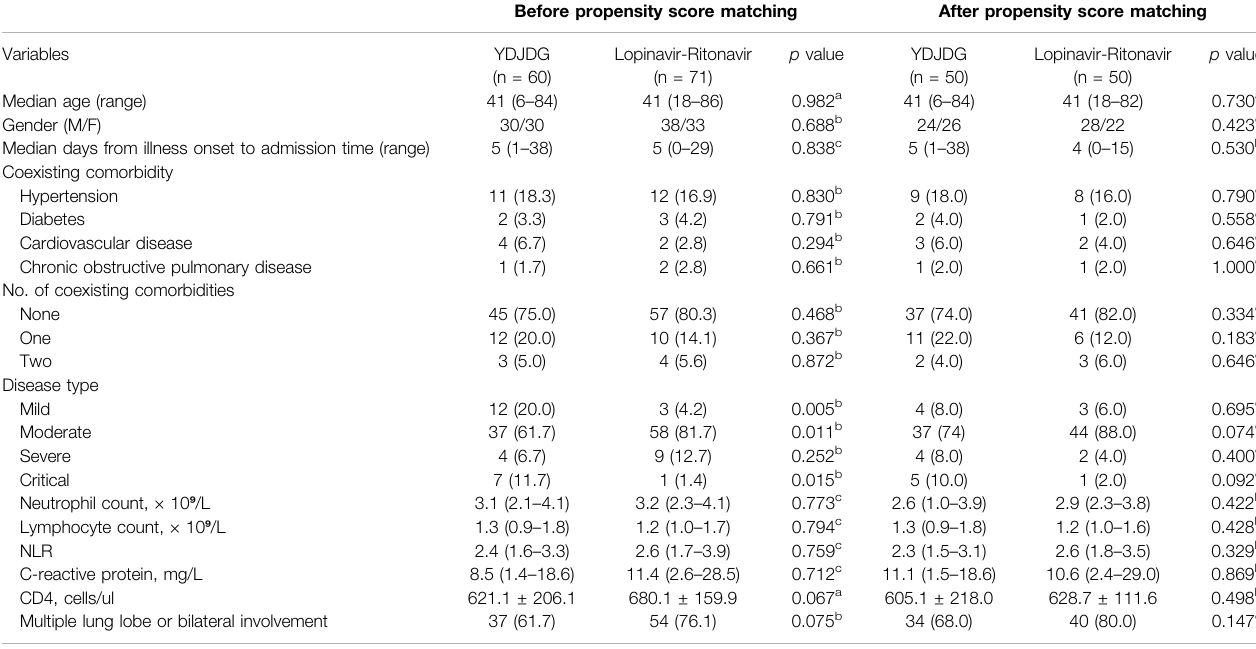
TABLE 3 | Baseline characteristics of COVID-19 patients before and after propensity score matching.